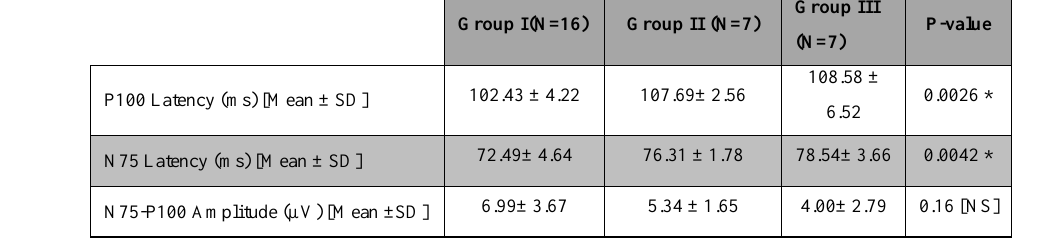
Table 15. Comparison of average VEP wave latencies and the average amplitude of both eyes between group I (having disease duration < 6 years), group II (having disease duration 6 to 11 years), and group III (having disease duration ≥ 11 years) diabetic patients by ANOVA test.